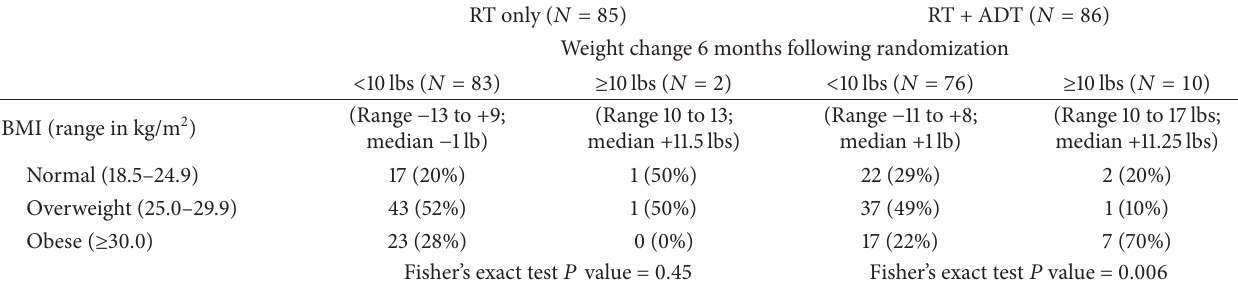
Table 3: Distribution of weight gain 6 months following randomization, stratified by treatment received and body mass